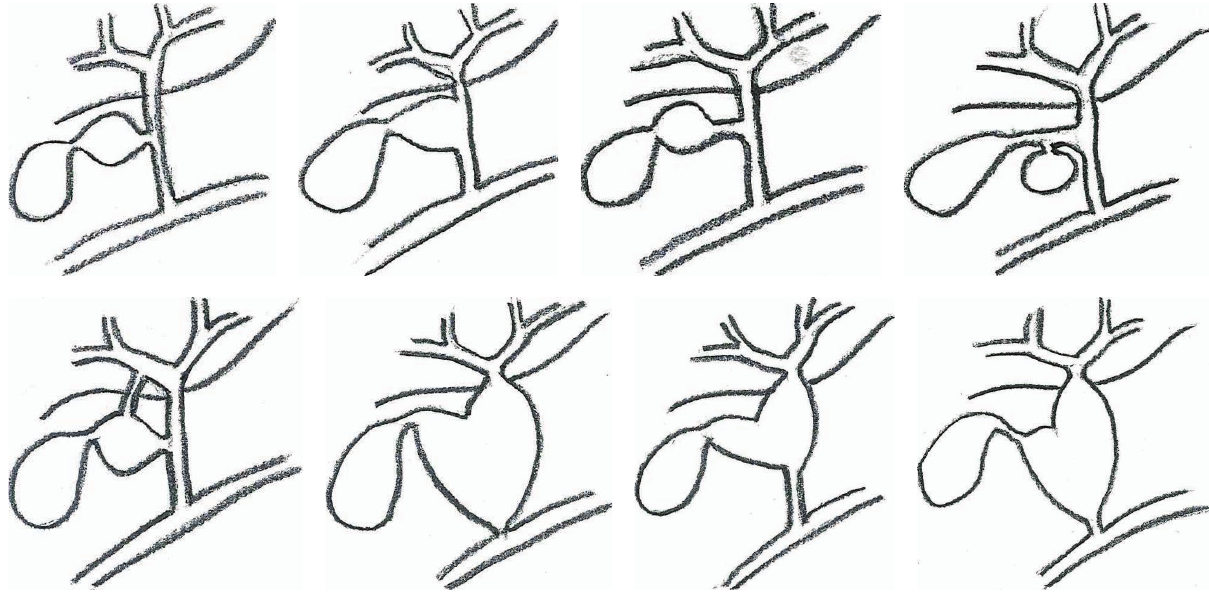
Figure 4: Schematic illustration of the type VI biliary cysts reported in the literature to